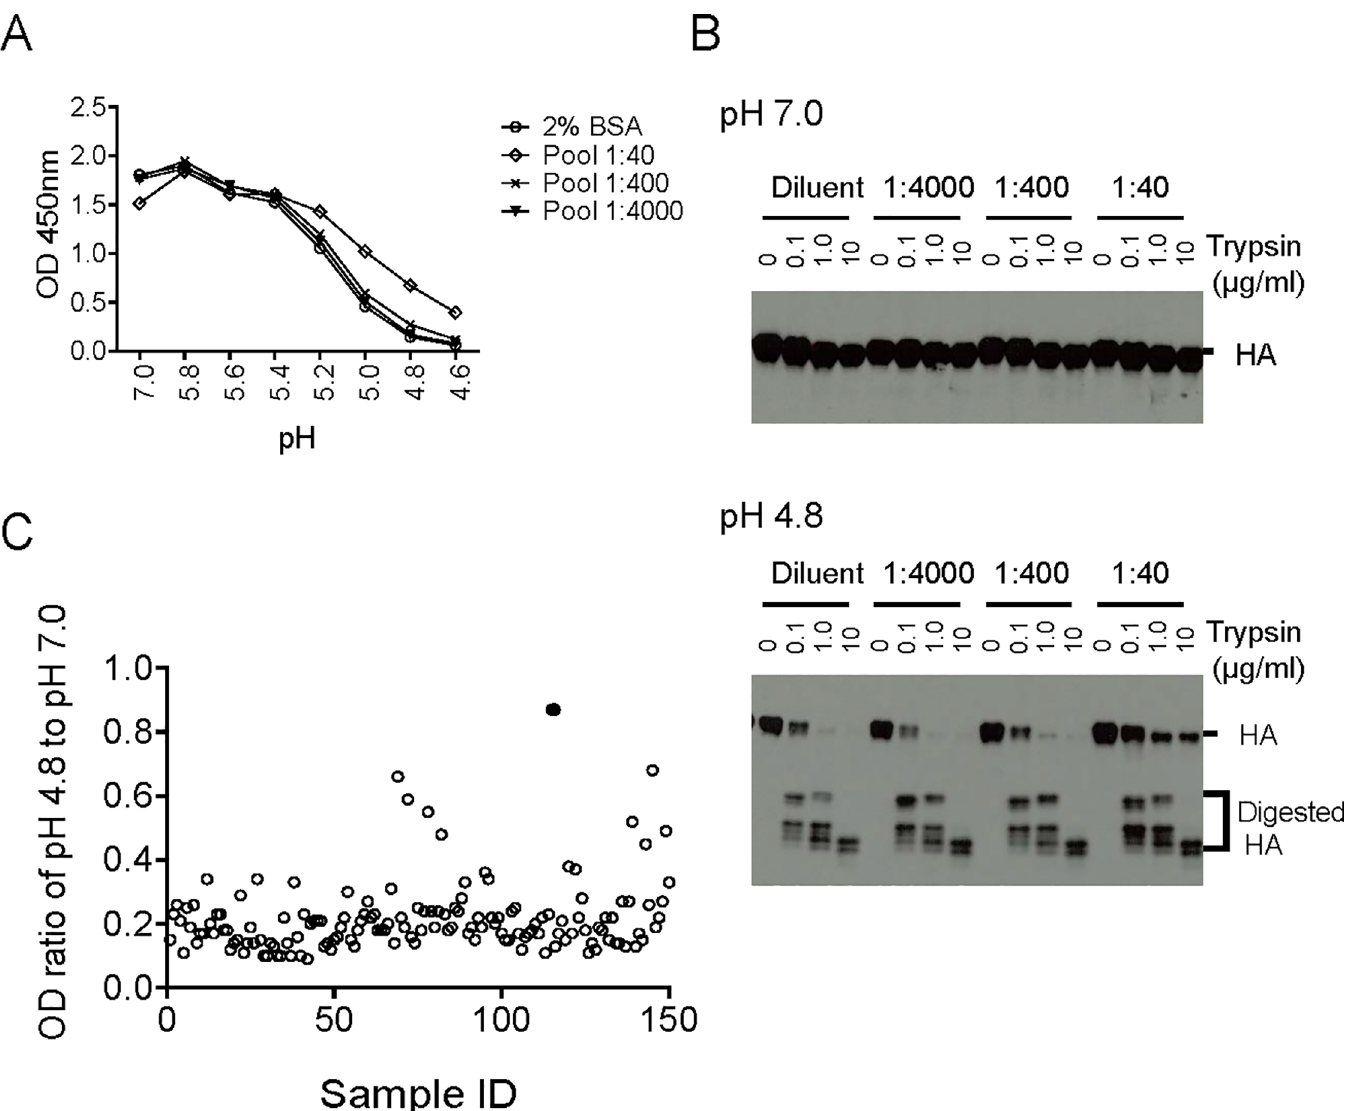
Fig 4. Low pH induced conformational changes of H3 rHA were inhibited by the human serum samples. A. Inhibition of low pH induced H3 rHA conformation change by a convenient human serum pool (Pool) in HCCIA. H3 rHAs bound to nickel-coated plates were treated with 100 μ l of 200 ng/ml trypsin to cleave HA0 into HA1 and HA2. rHA coated plates were incubated with diluent only, 1:4000, 1:400, or 1:40 diluted Pool for 1 hour. The plate was washed and treated with a range of pH buffers followed by fixation with 0.05% glutaraldehyde/PBS. An ELISA was performed using a pH-specific mAb, HC31, and detected by measuring the OD at 450 nm. B. Inhibition of H3 rHA low pH induced conformation change by human serum pool in the proteinase susceptibility assay. The proteinase susceptibility assay was performed to confirm HA low pH conformational changes in Fig 4A. H3 rHAs bound to nickel-coated plates were treated with 100 μl of 200 ng/ml trypsin to cleave HA0 into HA1 and HA2. The rHA coated plate was incubated with either diluent only, 1:4000, 1:400, or 1:40 diluted Pool for 1 hour followed by treatment with pH 7.0 or pH 4.8 buffer. The rHAs were digested with 0, 0.1, 1, or 10 μg/ml trypsin, the samples including digestion mixture and rHA left on plate were eluted from the nickel-coated plate by adding an equal volume of 2X non-reducing SLB supplemented with 1M imidazole and were separated by SDS-PAGE under non-reducing conditions. PAGE- separated proteins were transferred to a nitrocellulose membrane and probed with rabbit anti A/Aichi/2/68 (H3N2) antisera. HA proteins were detected by chemiluminescence with an HRP-conjugated secondary antibody. C. Detection of the CCI against H3 rHA in normal human sera in HCCIA. In total, 150 normal human sera collected from US residents were tested at 1:400 dilution by HCCIA as described in the Fig 4A legend. The OD ratio of HC31 at pH 4.8 to pH 7.0 was plotted; the highest ratio positive sample, #115, highlighted as a filled